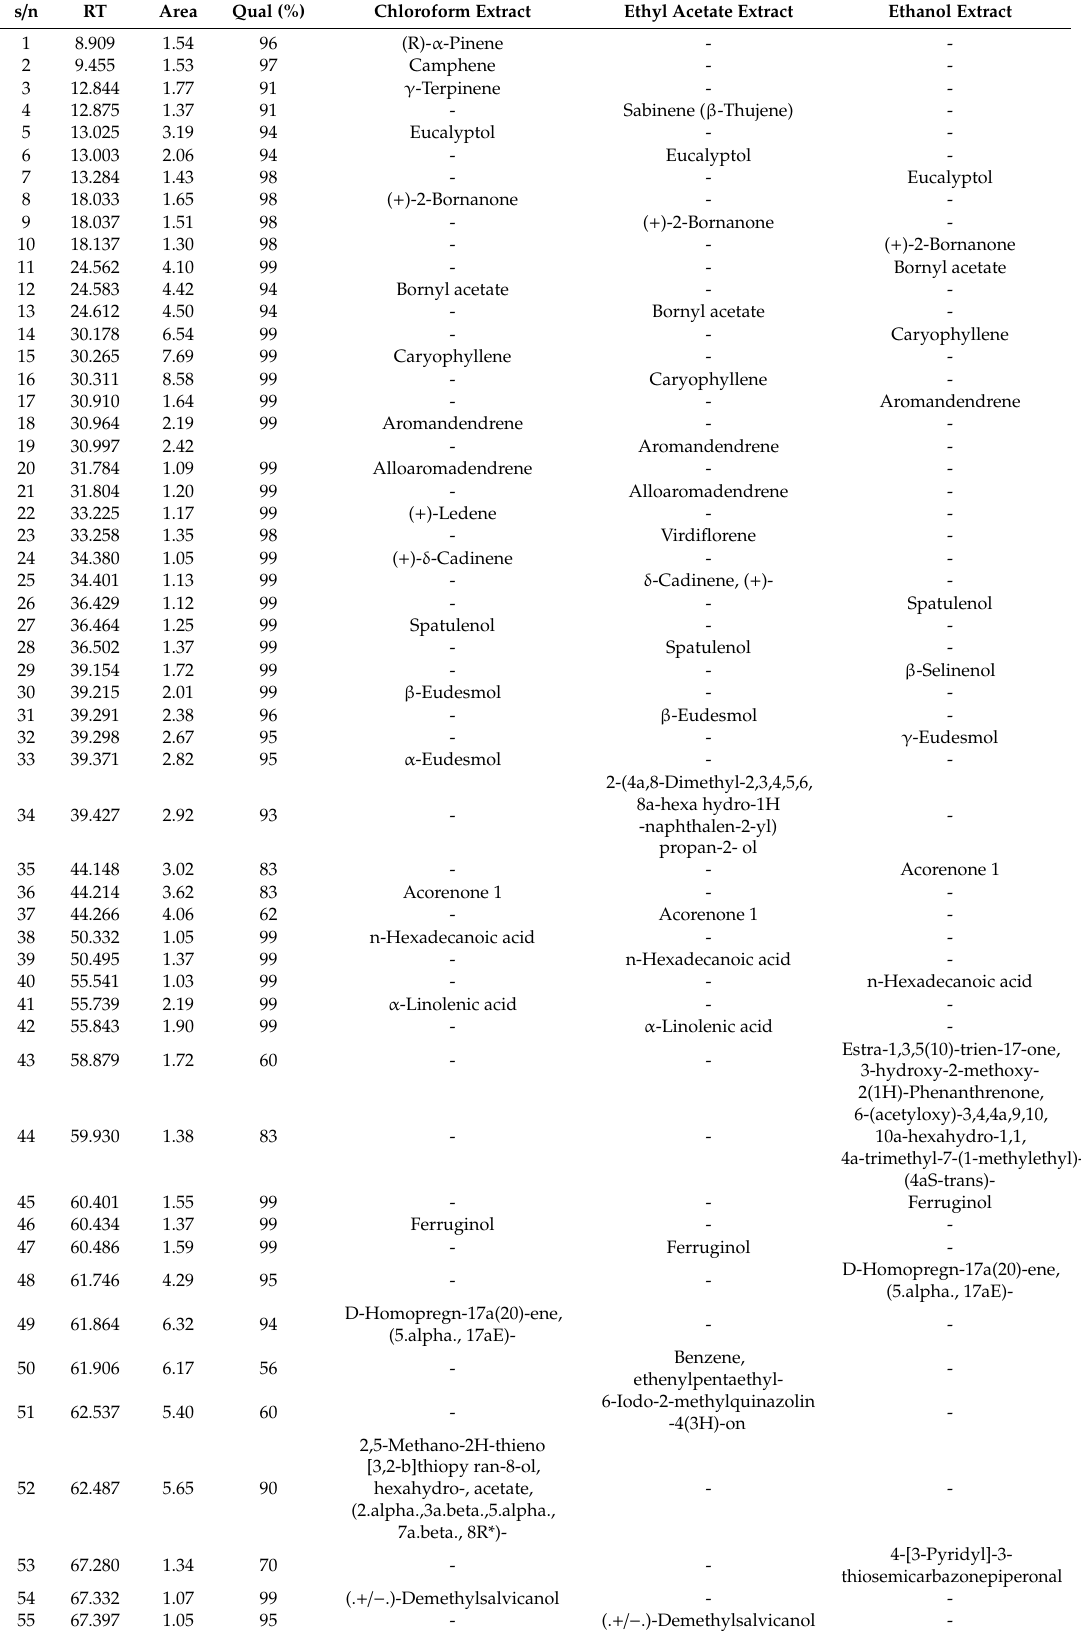
Table 1. GCMS profiles of chloroform, ethyl acetate and ethanolic extracts of O. genistifolia